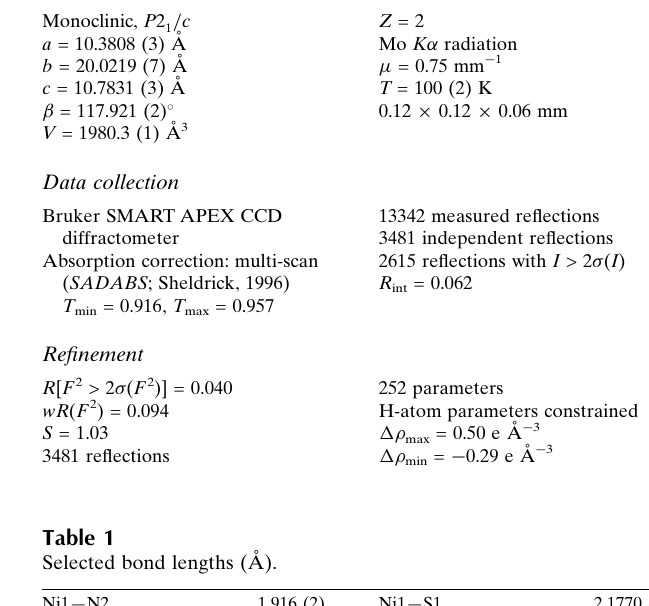
Selected bond lengths (A˚